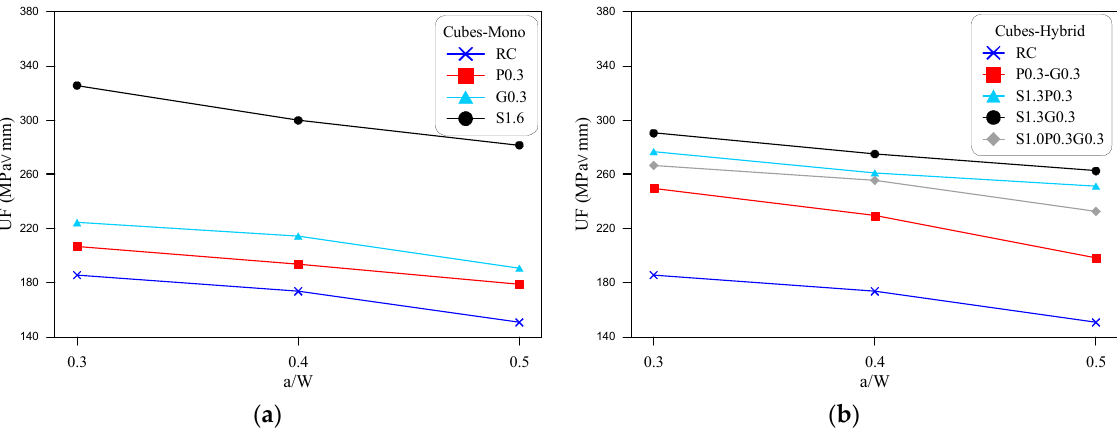
Figure 5. Mode II cube specimens’ fracture energy for different notch depth-specimen width (a/W)